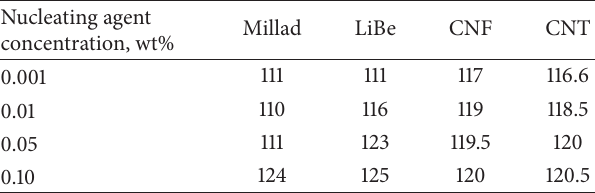
Table 2: Crystallization temperature ( ∘ C) of the iPP composites as a function of the nucleating agent